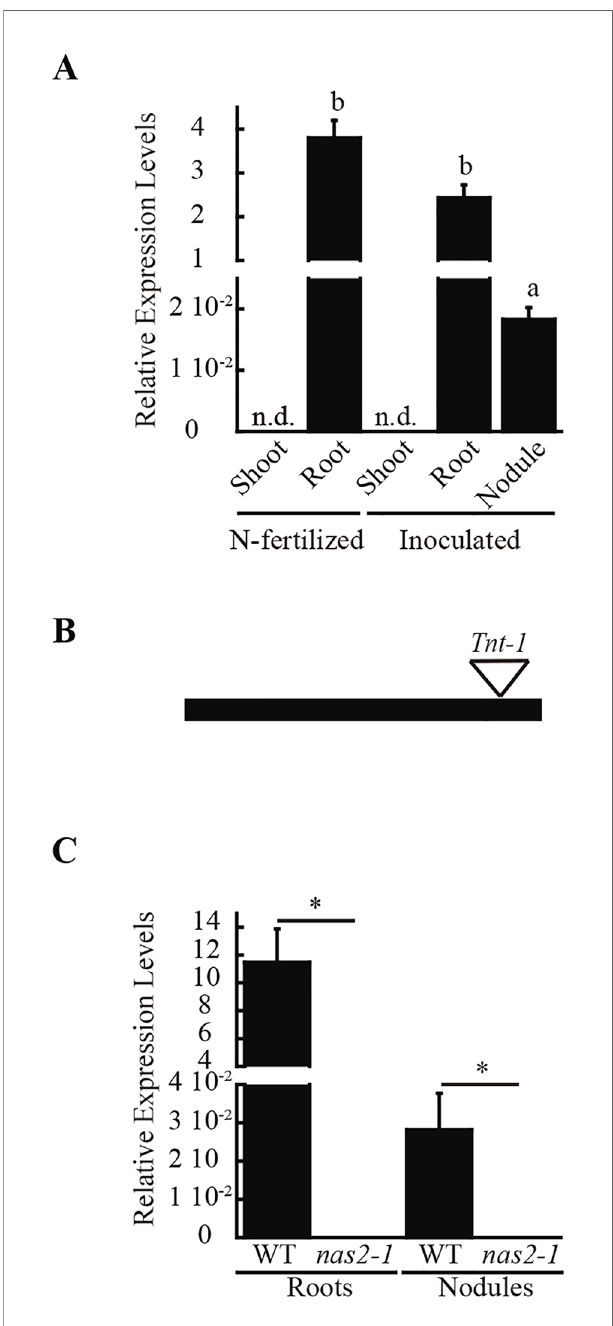
FIGURE 1 | MtNAS2 is expressed in roots and nodules of M. truncatula . (A) Expression data was normalized to the expression of ubiquitin conjugating enzyme E2 gene ( Medtr7g116940 ) as standard. Data are the mean ± SE of three independent experiments with 4 pooled plants. Different letters indicate statistical differences at P > 0.05 (Tukey t-test). (B) Tnt1 insertion in the only exon of MtNAS2 causes loss of MtNAS2 transcripts. (C) MtNAS2 expression was determined in 28 dpi roots and nodules of wild-type (WT) and nas2-1 plants. Data was relativized to the expression of ubiquitin conjugating enzyme E2 ( Medtr7g116940 ) and expressed as mean ± SE of three independent experiments with 4 pooled plants. *indicates statistical differences at P > 0.05 (Student